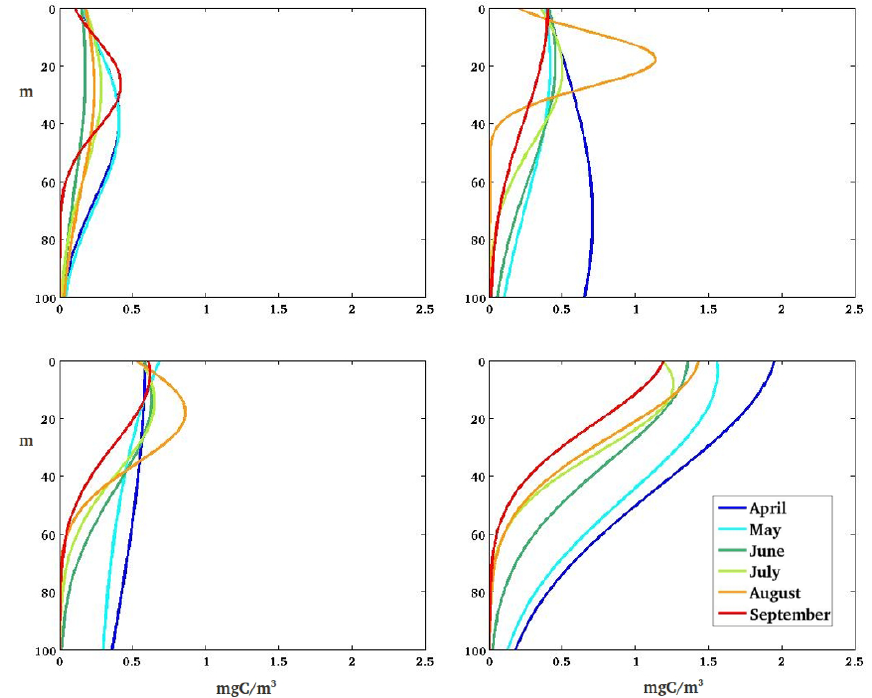
Fig. A2. Gaussians fitted to the median monthly chlorophyll profiles obtained for the four ranges of mean chlorophyll within the surface layer ( C pd ,mgCm − 3 ). Ranges: (I) < 0.3; (II) 0.3–0.45; (III) 0.45–0.7; (IV) > 0.7. Data are from R/V Polarstern and Maria S. Merian cruises (unpublished), and from ARCSS-PP database,